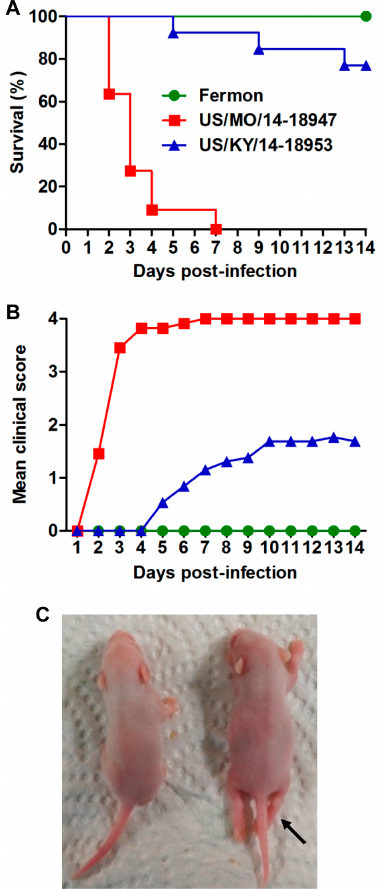
Figure 1. Comparison of the virulence of different EVD68 strains in mice. One-day-old ICR mice ( n = 11–13/group) were inoculated i.p. with 2.0 × 10 6 TCID 50 of Fermon, US/MO/14-18947 or US/KY/14-18953. All mice were monitored daily for ( A ) survival and ( B ) clinical score for 14 days. Clinical scores were graded as follows: 0, healthy; 1, lethargy and reduced mobility; 2, limb weakness; 3, limb paralysis; 4, death; ( C ) a representative picture of hind limb paralysis caused by US/MO/14-18947 at 6 dpi is shown (arrow). The mouse on the left side is a naive age-matched control.